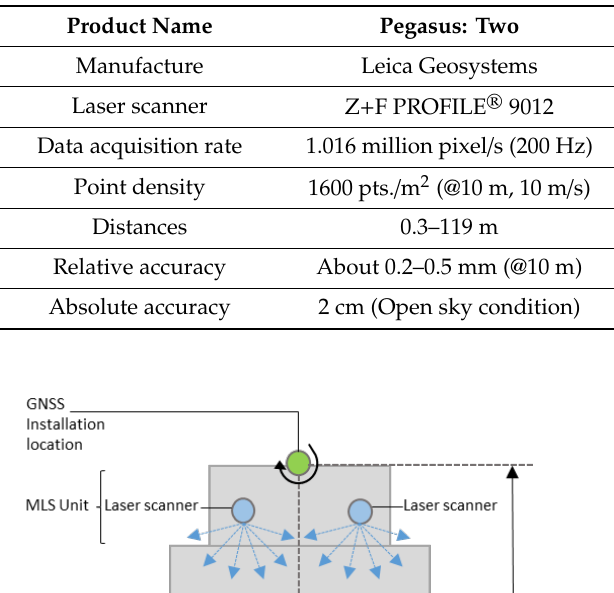
Figure 3. MLS sensor. Table 1. Sensor parameters.